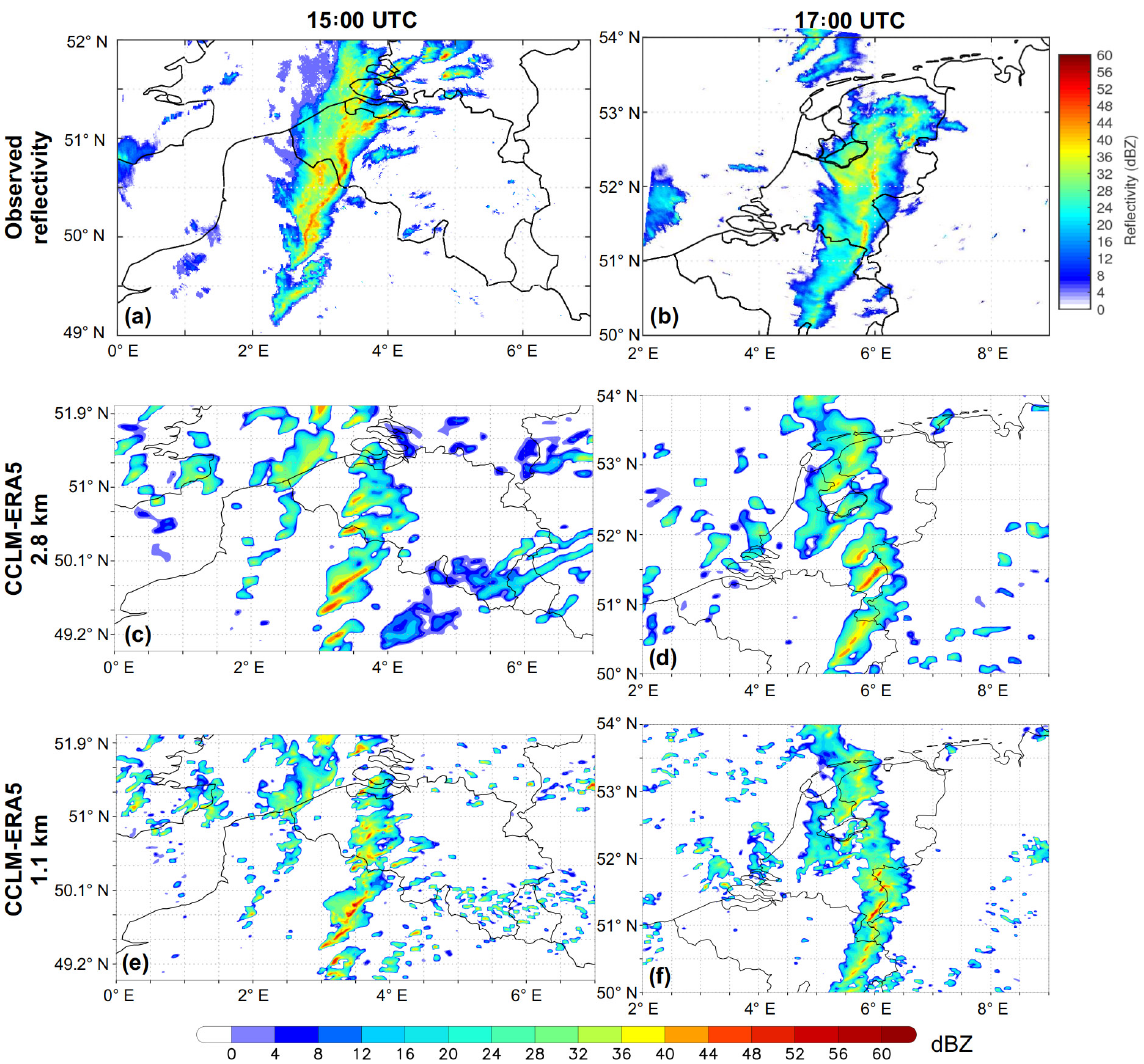
Figure 11. Comparison of the observed and modelled reflectivity at approximately 1.5km altitude at (a, c, e) 15:00UTC and at (b, d, f) 17:00UTC. (a) RMIB radar reflectivity composite (dBZ), (b) KNMI radar reflectivity composite (dBZ), (c, d) reflectivity from the CCLM- ERA5 2.8km simulation and (e, f) reflectivity from the CCLM-ERA5 1.1km